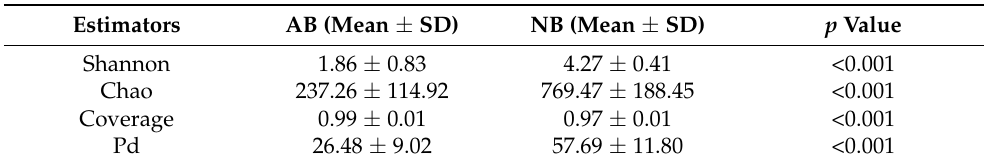
Table 1. Alpha diversity index of B. calyciflorus -associated bacteria (AB) and bacterioplankton (NB) (Wilcoxon rank-sum test).